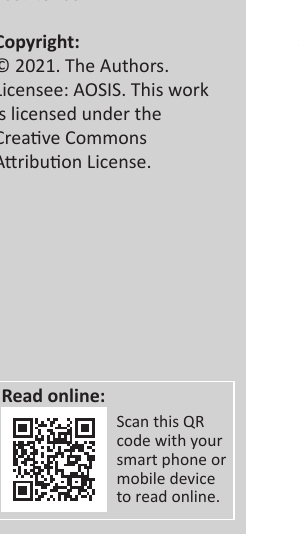
FIGURE 1: The Next5 logo and